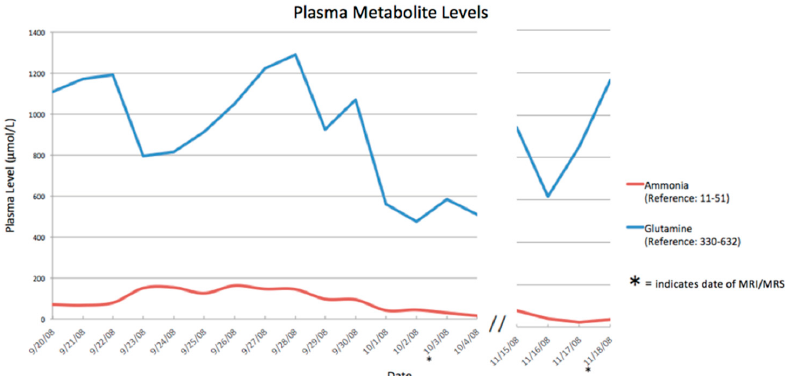
Figure 3. Metabolic crises. Sequential ammonia and glutamine levels obtained through daily monitoring over a 19-day period. The most striking observation is the persistent elevation of glutamine (normal in our lab is 396–740 µmol/L). Despite normal ammonia levels (normal in our lab is <50 µmol/L). Int. J. Neonatal Screen. 2016 , 2 , 10